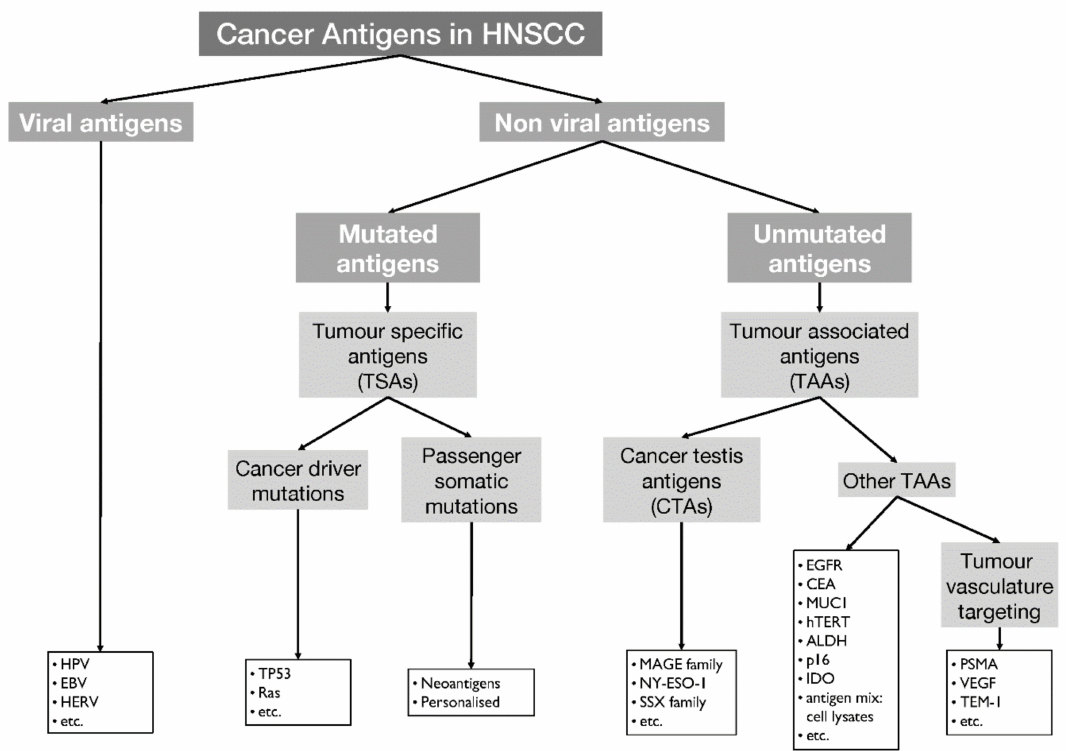
Figure 1. Overview of cancer antigens that are potential therapeutic targets in head and neck squamous cell carcinoma (HNSCC). TSA = tumour-specific antigen, TAA = tumour-associated antigen, CTA = cancer testis antigen, HPV = human papilloma virus, EBV = Epstein–Barr virus, HERV = human endogenous retroviruses, MAGE = melanoma-associated antigen, NY-ESO-1 = New York esophageal squamous cell carcinoma-1, SSX = synovial sarcoma X, EGFR = epithelial growth factor receptor, CEA = carcinoembryonic antigen, MUC1 = mucin-1, hTERT = human telomerase reverse transcriptase, ALDH = aldehyde dehydrogenase, IDO = indolamin-2,3-dioxygenase, PSMA = prostate-specific membrane antigen, VEGF = vascular endothelial growth factor, TEM-1 = tumour endothelial marker